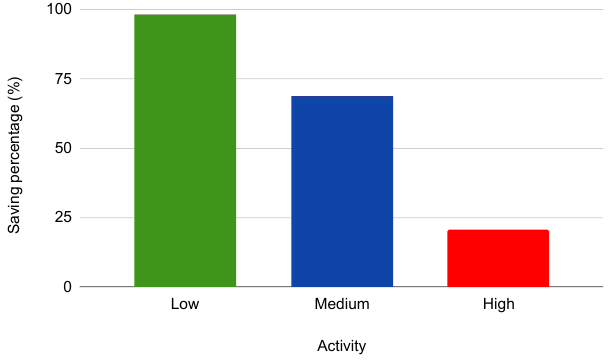
Figure 7. Percentage of energy savings by activity ranges when using the BlueField.